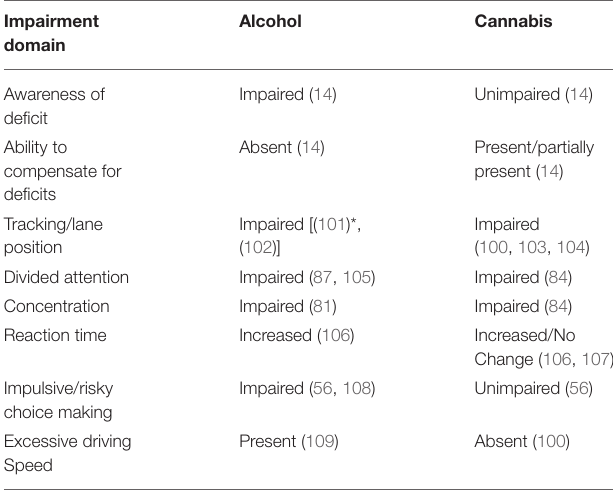
TABLE 4 | Contrasting alcohol vs. cannabis effects on simulated and actual driving behavior and associated